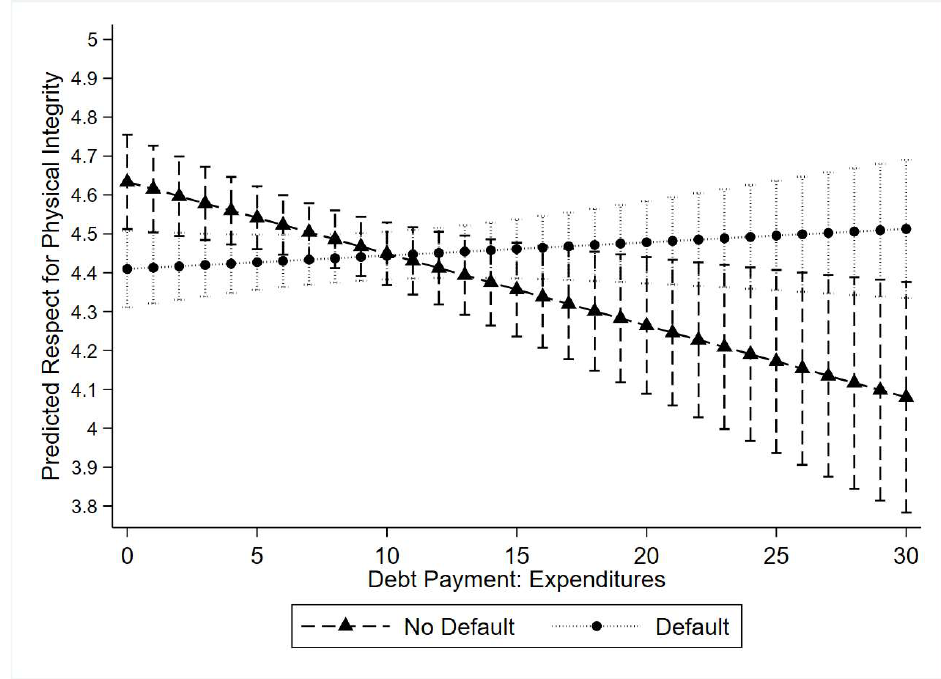
Figure 5. Marginal Effects of Default and Non-Default at Increasing Debt:Expenditures.